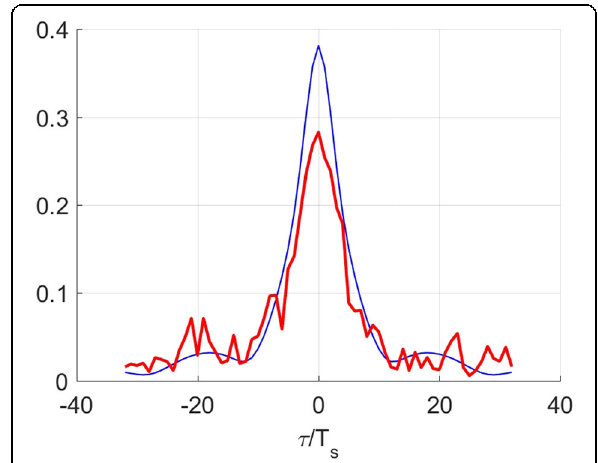
Fig. 9 Case B: magnitude of the cyclic correlogram of the de-warped data (thick red) and of the data before warping (thin blue), as functions of α / f s and τ / T s ð f s ¼ 1 = T s Þ . (Exact warping frequencies, SNR ¼ (cid:7) 10 db)